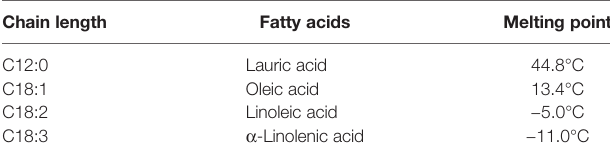
TABLE 1 | Melting point of commonly used fatty acids in lipid emulsions (Gunstone et al., 2007). Chain length Fatty